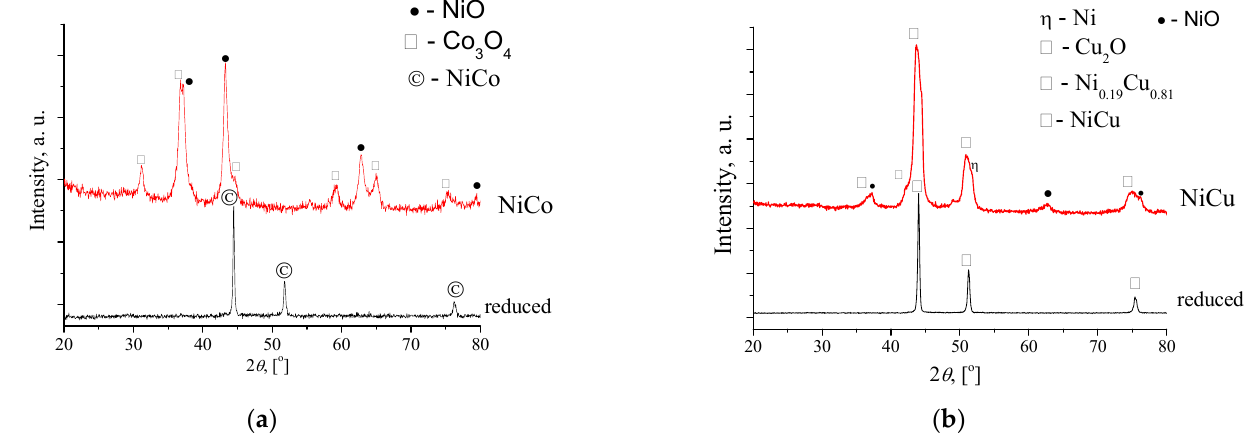
Figure 3. XRD patterns of the ( a ) NiCo and ( b ) NiCu powdered samples calcined at 500 °C in air (curves NiCu and NiCo) and after treatment at 600 °C in hydrogen (reduced).